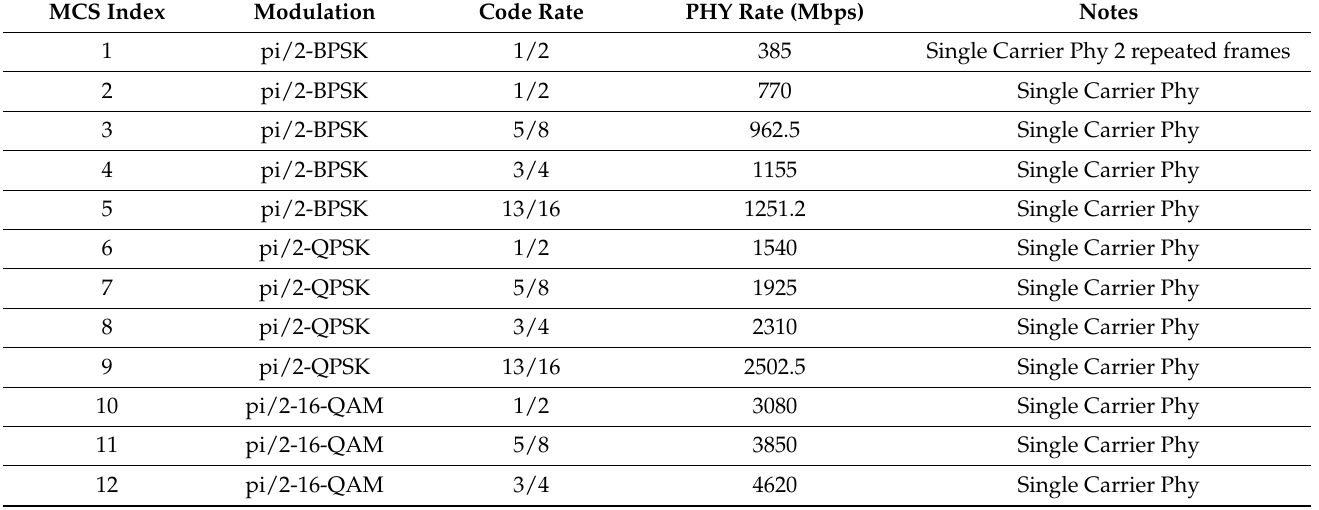
Table 1. SC_PHY Modulation and Coding